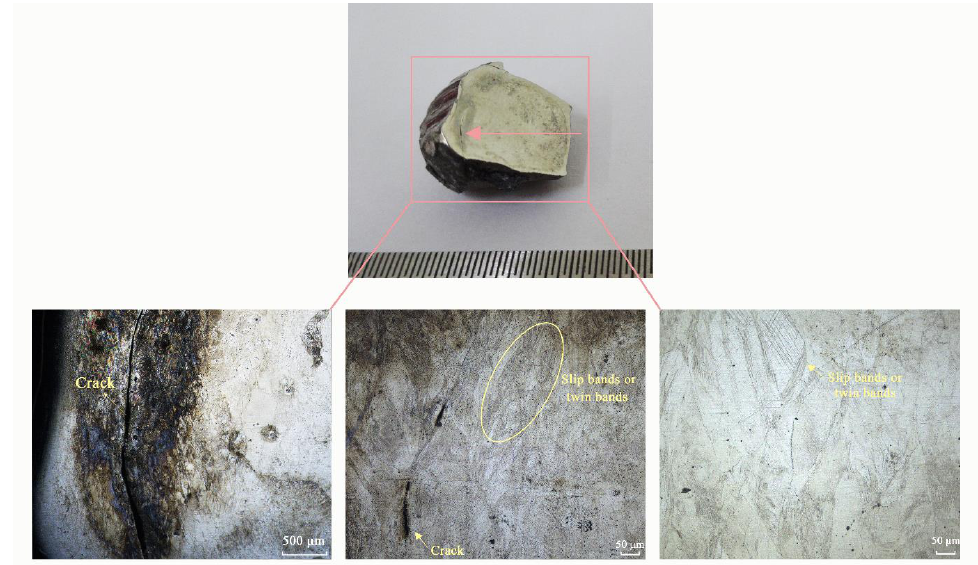
Figure 20. OM images of the FeNiCoCr HEA LRP annealed at 850 °C, v = 1052 m/s.